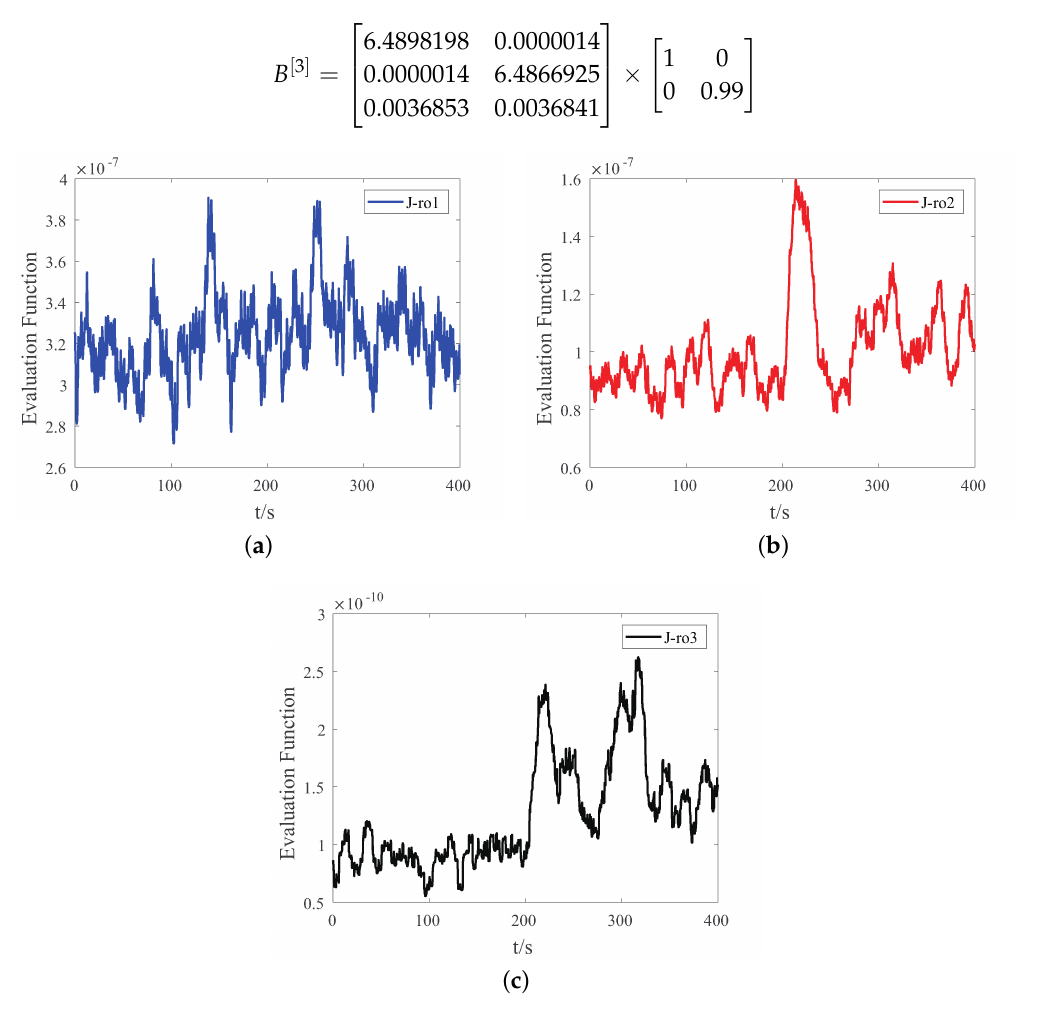
Figure 7. Simulation results of robust observer with fault modes i = 1 occurring at 200 s: ( a ) evaluation function of the first robust observer; ( b ) evaluation function of the second robust observer; ( c ) evaluation function of the third robust